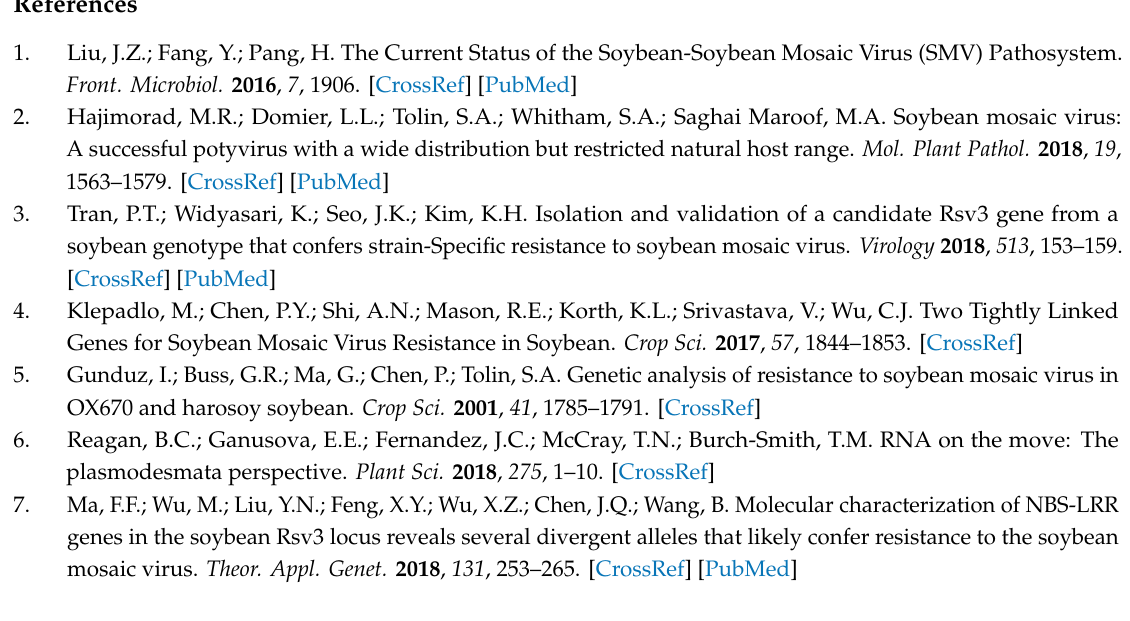
Figure S1. Expression levels of Rsv3 gene in response to G7H infection, ABA treatment, or both. The first trifoliate leaf was sprayed with ABA one day before G7H infection, and received another treatment after three days. Leaves were collected at 5 dpi for expression